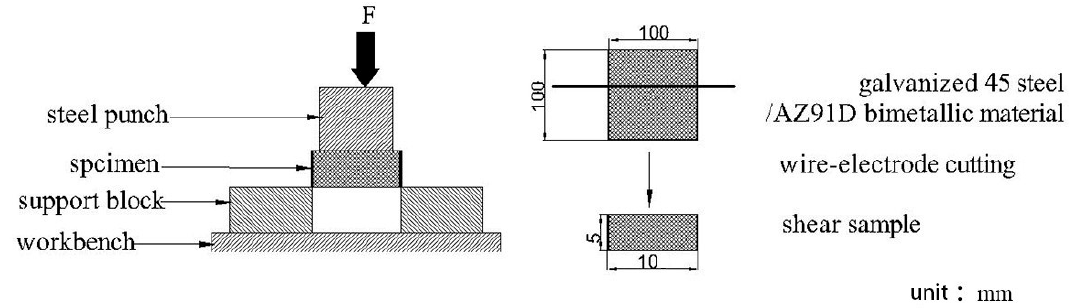
Figure 2. Schematic illustrations of the shear test.